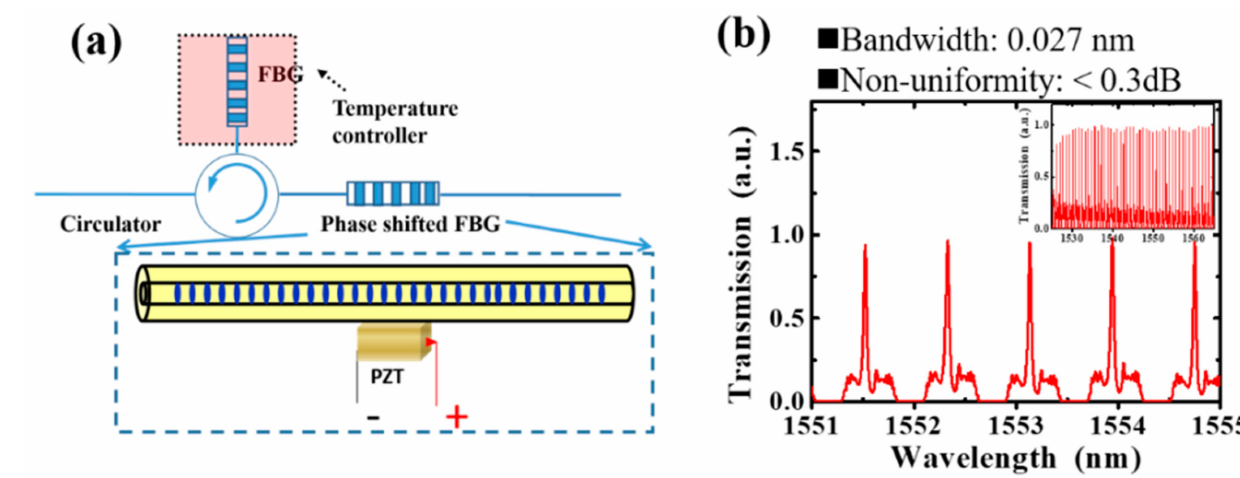
Figure 8. ( a ) The experimental configuration for the PS-FBG-based comb filter. ( b ) Transmission spectrum of the comb filter system shown in left side, where the inset shows the whole 51-channel spectrum. Adapted with permission from ref. [65]. © [2022]